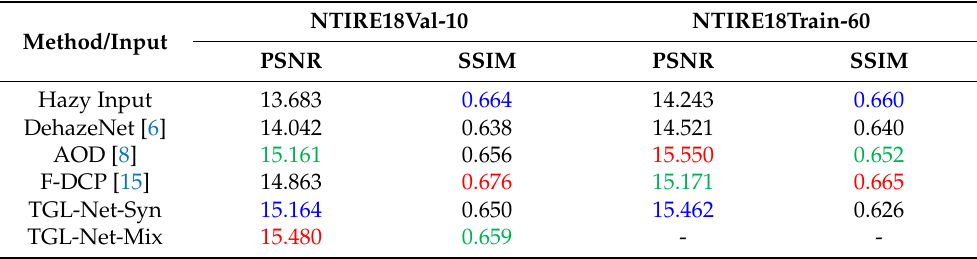
Table 3. Average peak signal-to-noise ratio/structural similarity index (PSNR/SSIM) values on the NTIRE 2018